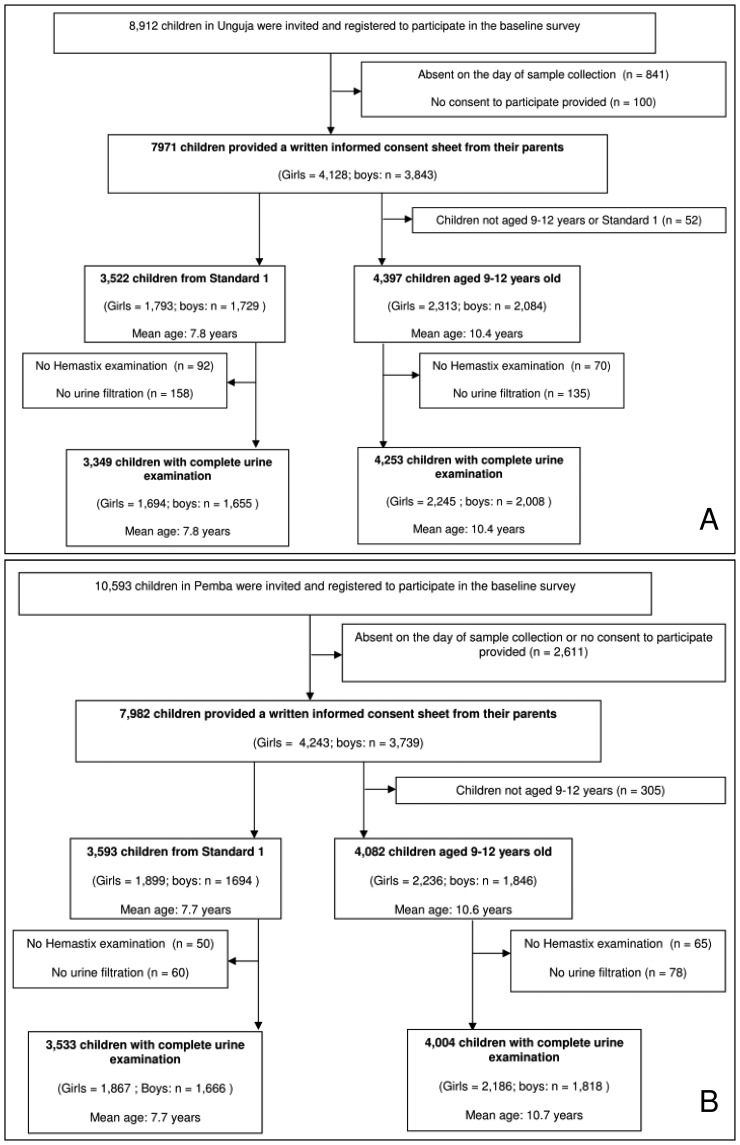
Flowchart detailing study participation in the schools surveyed in Unguja (A) and Pemba (B) in January till March, 2012.